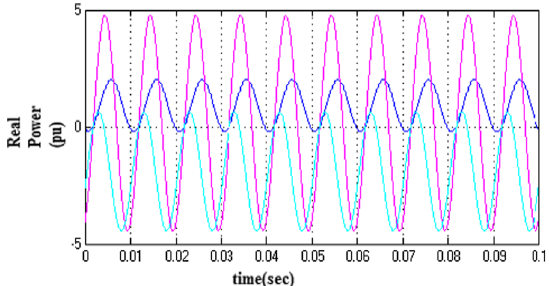
Fig. 15 Real power flow at bus 4 without TSC